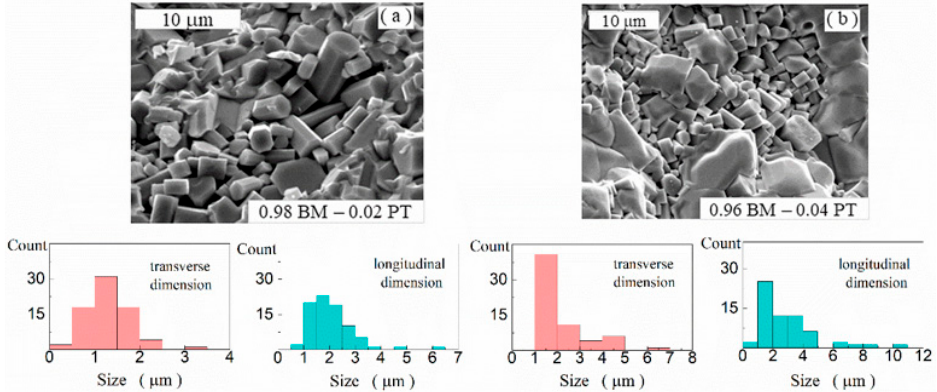
Figure 2. Secondary electron images obtained for 0.98 BM–0.02 PT ceramics ( a ) and 0.96 BM–0.04 PT ceramics ( b ). Histograms show grains’ transverse and longitudinal size distribution.